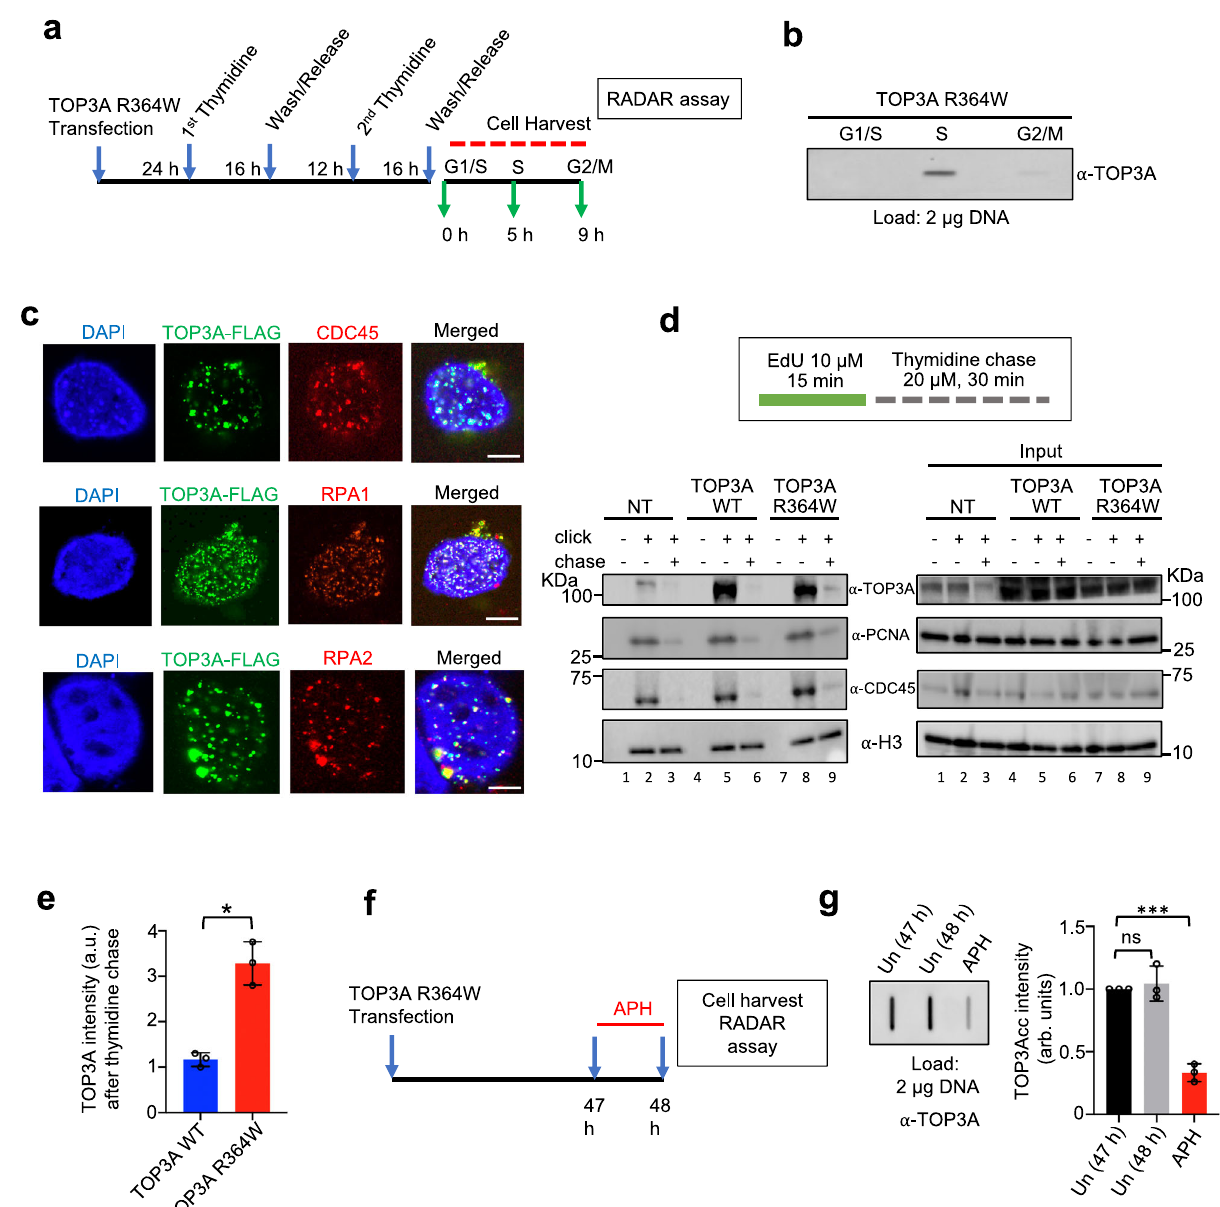
Fig.2|TOP3Accsarepredominantlyformedinreplicativecells.a Outlineofthe experimental protocol for transfection, cell synchronization, followed by RADAR assay in U2OS cells with ectopic expression of TOP3A-R364W. Cells at different phasesofcellcyclewereharvestedattheindicatedtimesandprotein-DNAadducts wereprobedbyRADARassay. b RepresentativeslotblotforTOP3Accsdetectionby RADARassayfromcellsharvestedasindicatedinpanelA.TOP3Accsweredetected with anti-TOP3A antibody. c U2OS cells expressing FLAG-tagged TOP3A-R364W after 48h transfection were pre-extracted, fi xed and analyzed by confocal micro- scopy. Representative images showing TOP3A co ‐ localization with CDC45, RPA1 and RPA2. TOP3A foci were detected using anti-FLAG antibody. Scale bars: 10 μ m. d Upperpanel:work fl owoftheiPONDexperiments;clickreactionswereperformed atthe end of the 15min EdU pulseorfollowing thymidine chase.Lower leftpanels: lysates form mock-transfected (NT), TOP3A-WT- and TOP3A-R364W-transfected cells were immunoblotted with the indicated antibodies. H3 was used as a loading